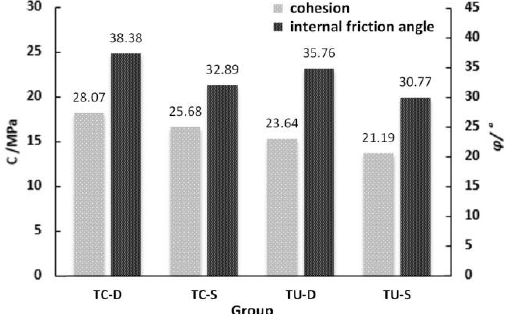
Figure 3. Strength parameters of sandstone specimens.